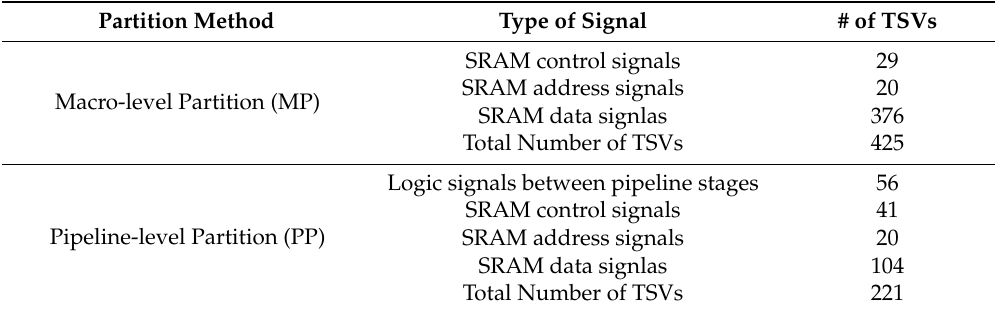
Table 4. TSV usage